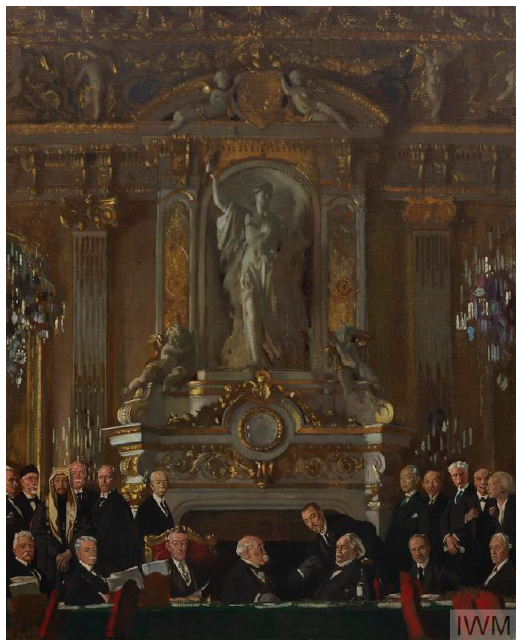
Figure 1. William Orpen. A Peace Conference at the Quai d’Orsay. 1919. Oil on Canvas. 145 cm × 121 cm. Imperial War Museum. Art. IWM. ART 2855.